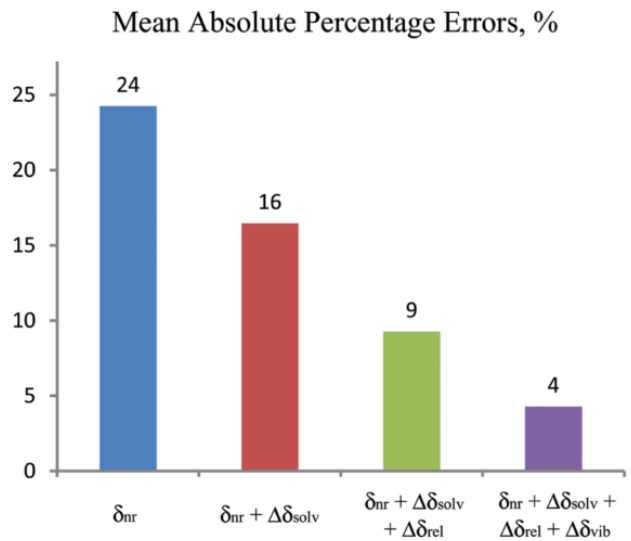
Figure 2. MAPEs of 125 Te NMR chemical shifts of six organotellurium compounds calculated at the GIAO-PBE0 level, taking into account solvent, relativistic, and vibrational corrections in comparison with the experiment. Reproduced from Ref. [629] with permission from the American Chemical Society.